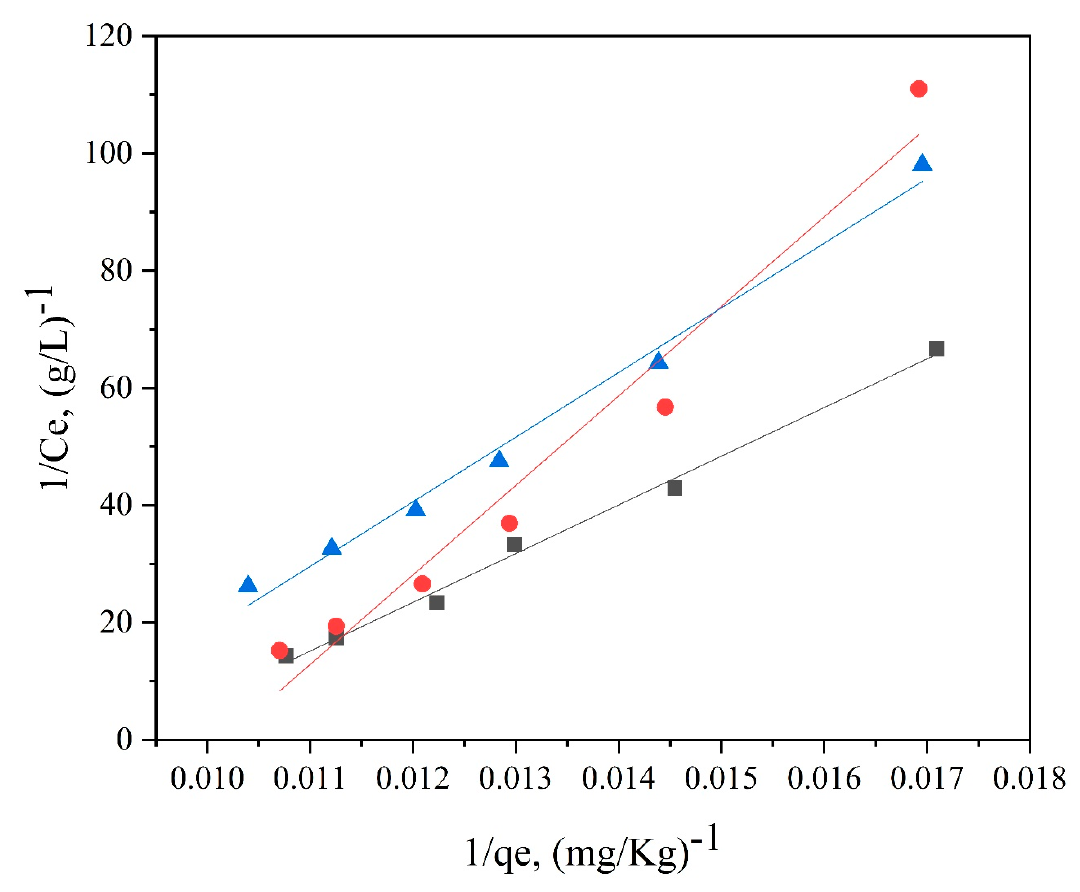
Figure 13. Langmuir model of dyeable spandex dyed with neutral red G.